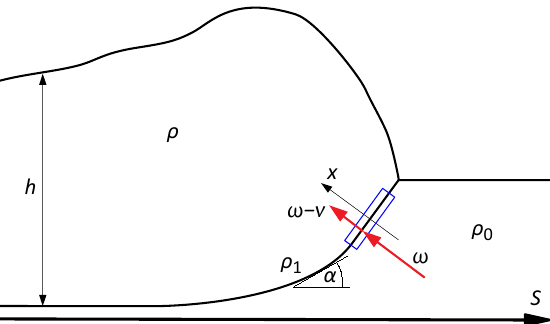
Figure 1. Schematic representation of the integration volume (blue box) for the mass and momentum jump conditions across the interface between snowcover (density ρ 0 ) and avalanche (density ρ 1 ). The normal velocity components on both sides of the interface (red arrows) refer to the coordinate system moving with the